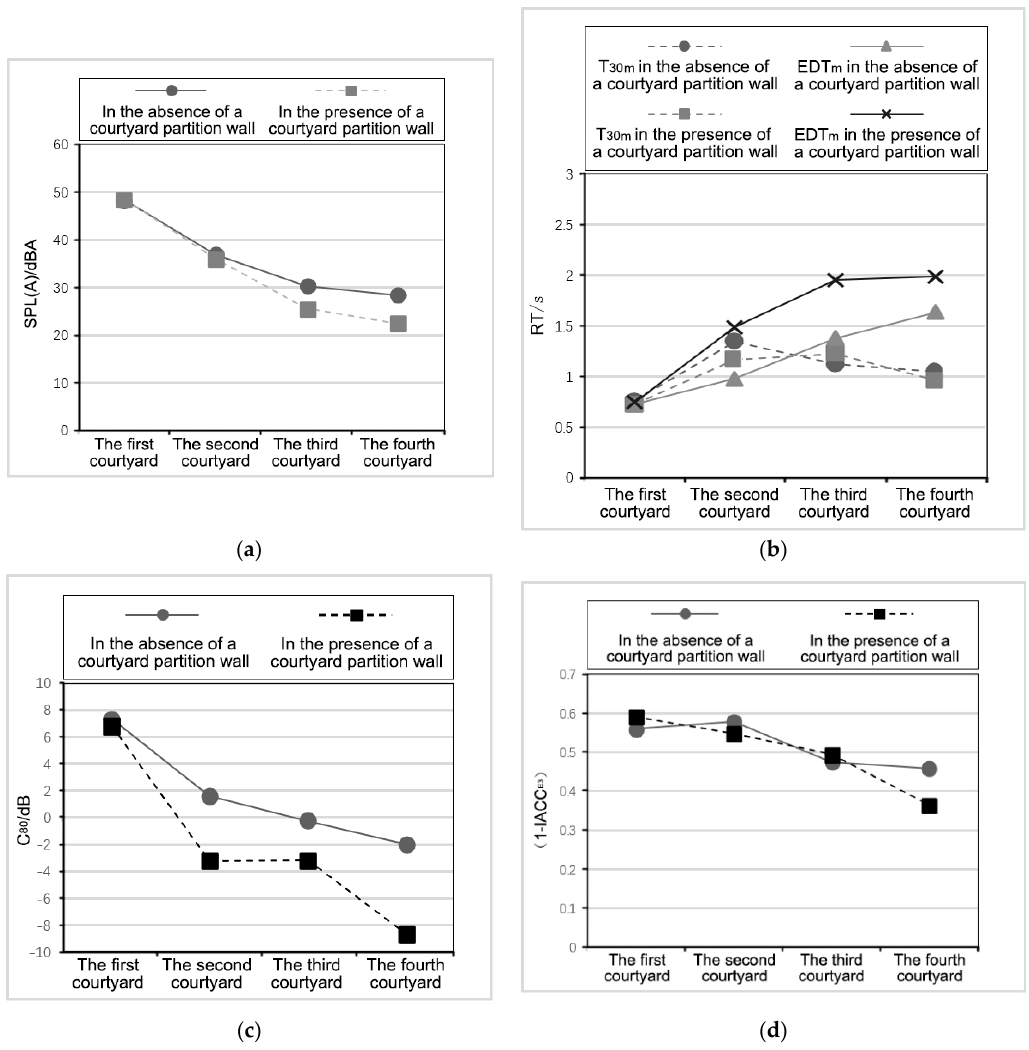
Figure 7. Diagrams of the effects of courtyard partition walls on courtyard sound fields. ( a ) Variation in SPL(A). ( b ) Variation in RT. ( c) Variation in C 80 . ( d ) Variation in (1 − IACC E3 ).